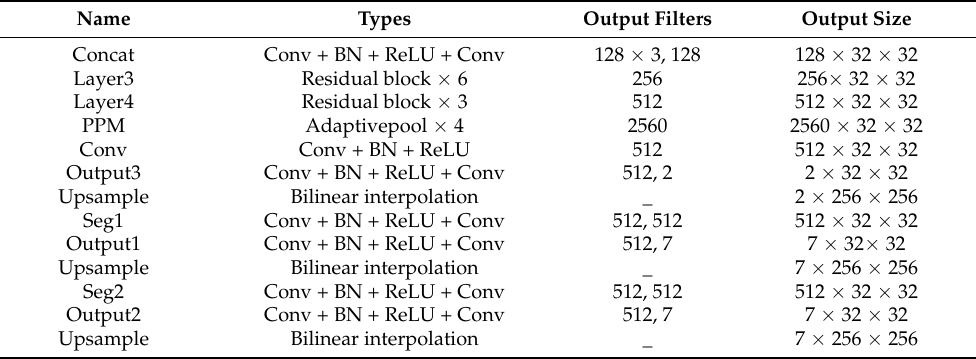
Table 3. Configuration of the generative change field